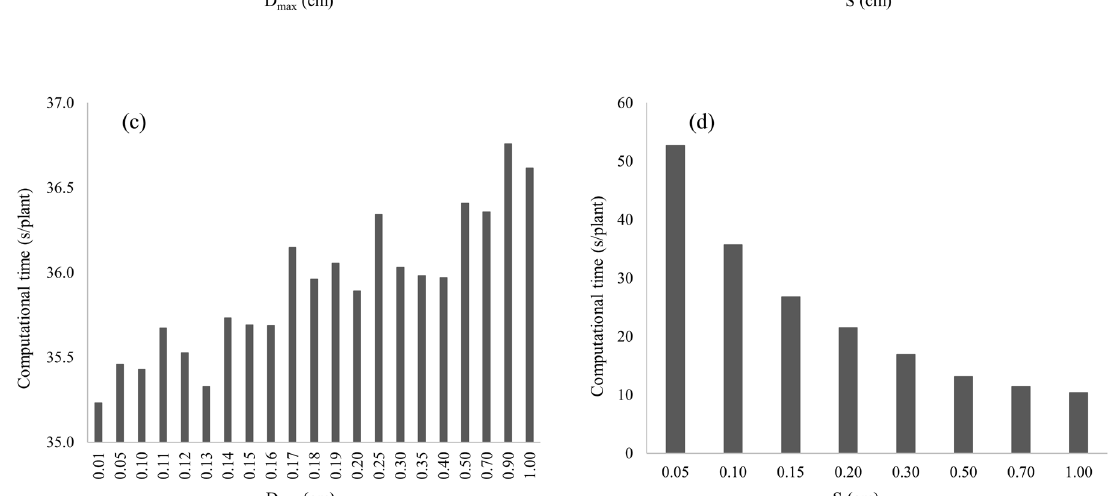
Table 1. Descriptive statistics of estimated strawberry canopy volume using three approaches (slic- ing and summing slice volume, voxel-grid, and 3D convex hull); errors are provided in terms of mean bias error (MBE), root mean square error (RMSE), root mean square percent error (RMSPE), coefficient of determination (R 2 ) between estimated and reference volume ( n = 12), and average com- putational time per plant.